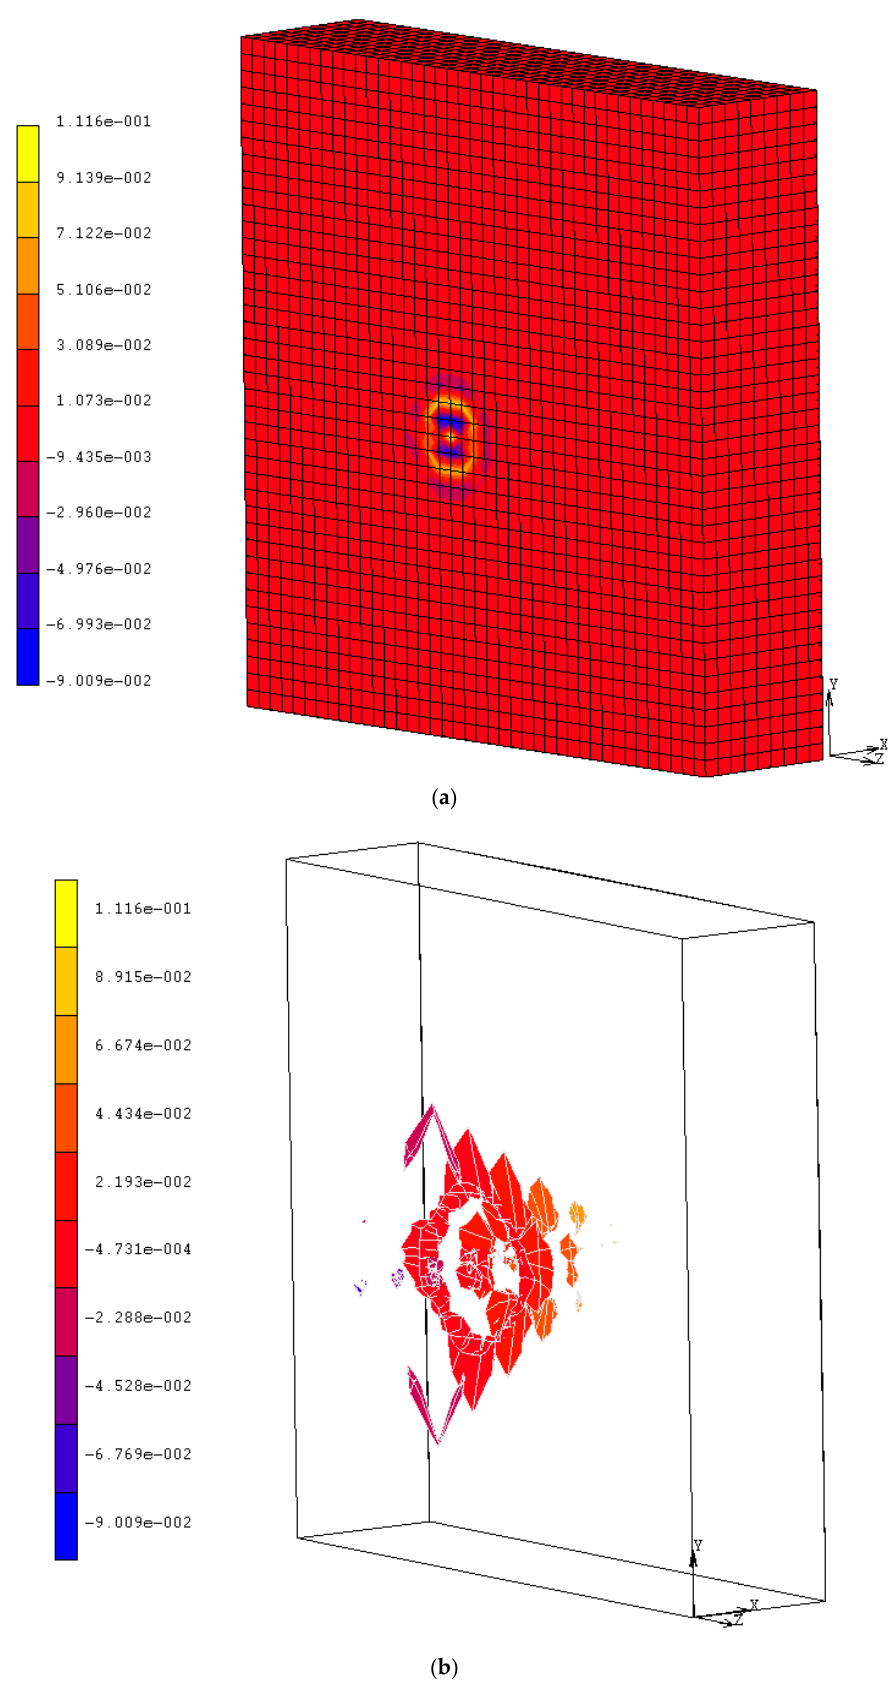
Figure 3. Penetration depth ( a ) of about 10 cm and fragment projection ( b ) at t = 2.1 10 − 3 sec.